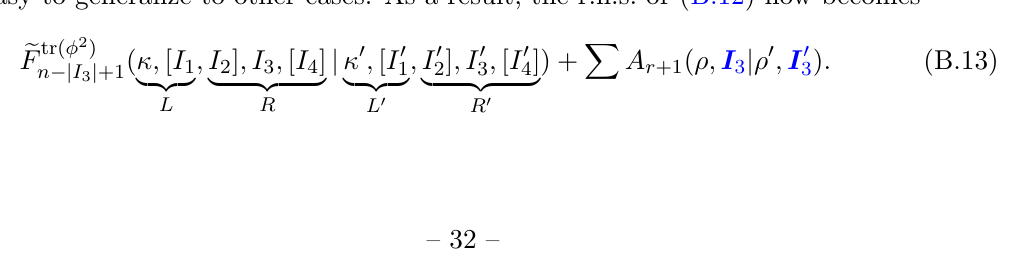
Figure 8. Factorization channels for F tr( φ the mutual partial triangulation and each red dashed line represents a diagonal allowed to be added. Every diagonal represents two factorization channels, e.g. the black one stands for s